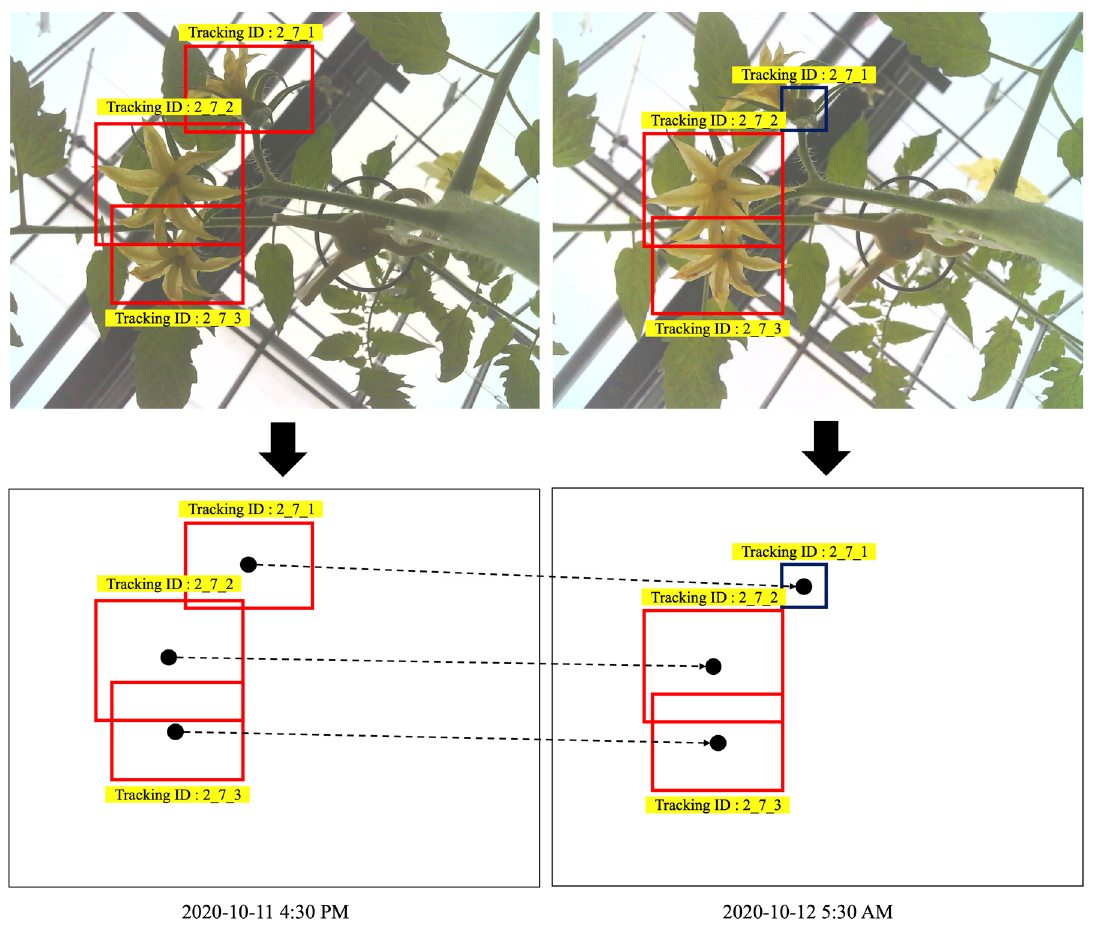
Figure 10. Bloomed flowers and immature fruits tracking in tomato.